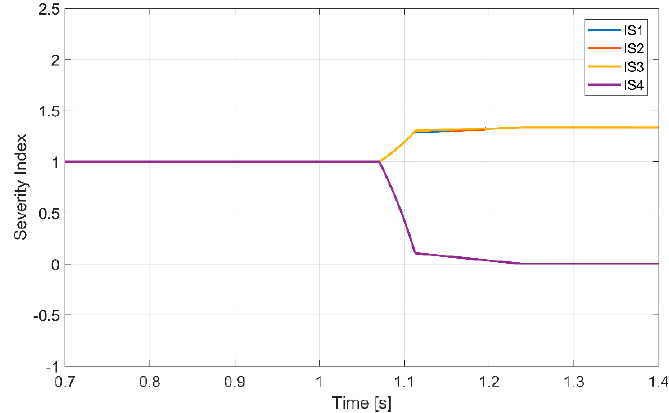
Figure 7. Diagnostic variables associated with the motor winding currents of the SRM at 60 rpm in normal condition and open-circuit failure of power device S 1 D (simulation result).